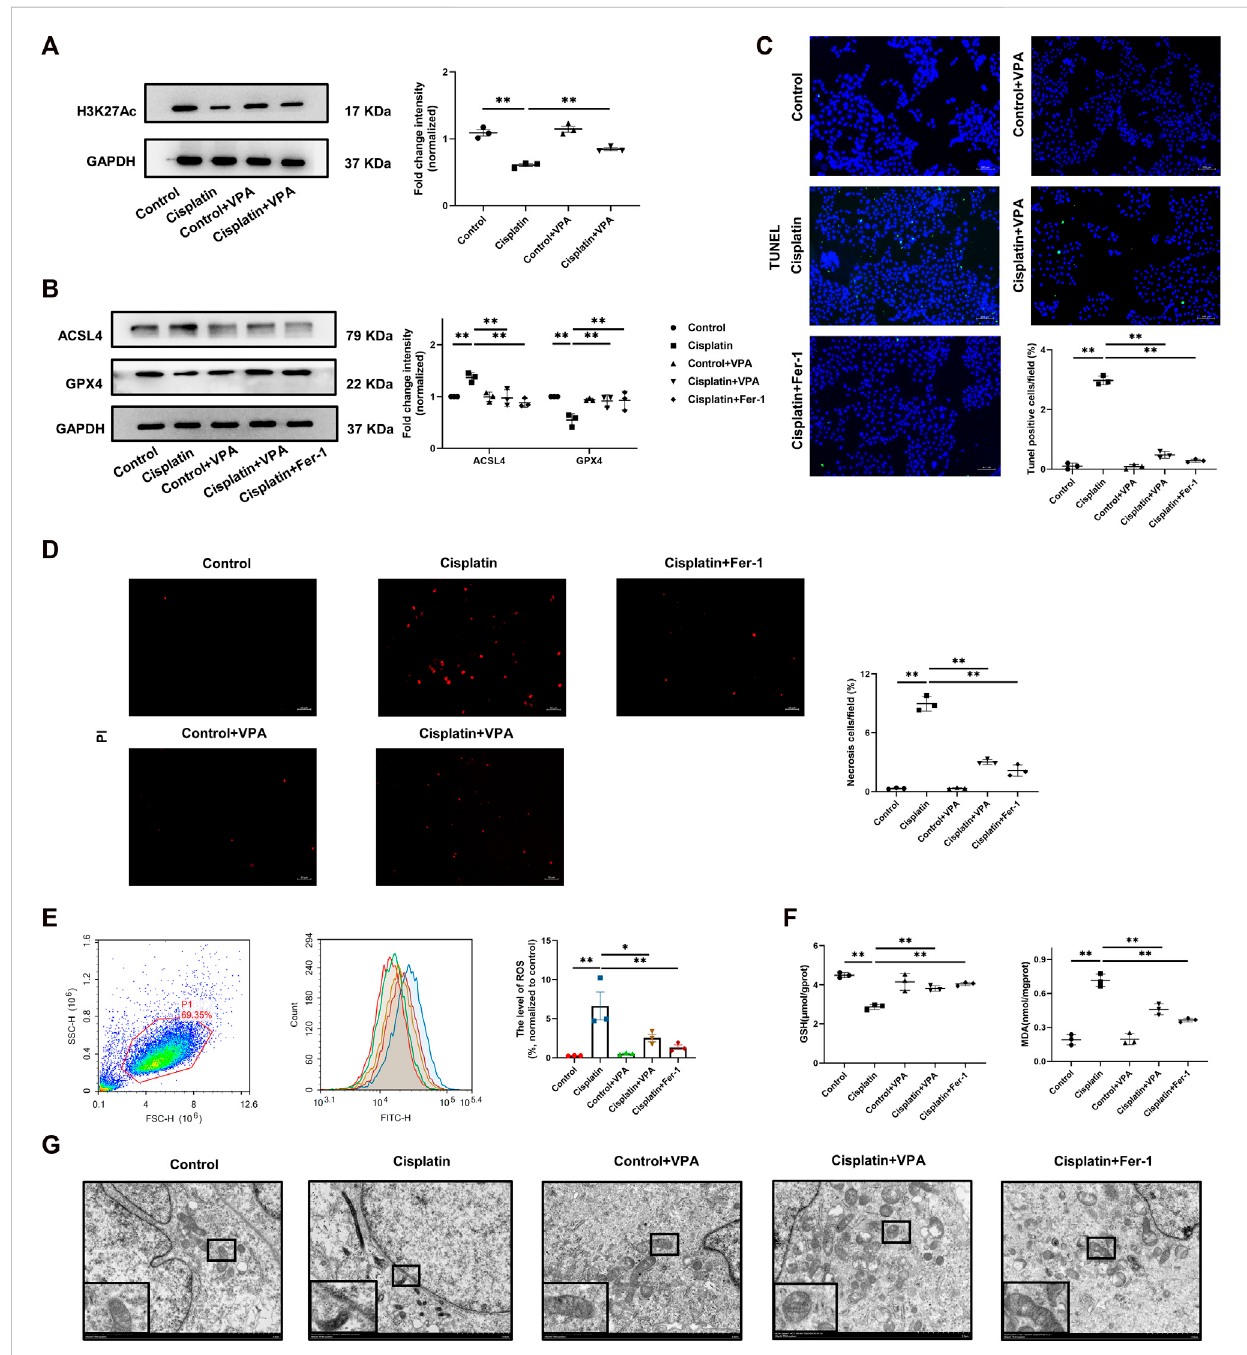
FIGURE 5 The cisplatin-induced ferroptosis is improved by VPA in HK-2 cells. Representative images of Western Blot and quanti fi cation of H3K27Ac in HK-2 cells stimulated by cisplatin (A) . Representative images of Western blot and quanti fi cation of ACSL4 and GPX4 in HK-2 cells stimulated by cisplatin (B) . PI staining (red) and statistical analysis of cell death in each group in HK-2 cells stimulated by cisplatin. Scale bar = 50 μ m (C) . TUNEL fl uorescence staining andstatisticalanalysisofapoptosiscellsineachgroupinHK-2 cellsstimulatedbycisplatin.Green fl uorescenceinpicturesrepresentpositivesignals ofapoptosiscells,whileblue fl uorescencerepresentsnuclearstaining (D) ,Scalebar=200 μ m.TheproductionofROSwasdetectedbyROSassaykitand waspresentasFITC-HvalueinP1region (E) .TheproductionofGSHandMDAincisplatin-stimulatedHK-2cells (F) .Transmissionelectronmicroscopyof HK-2 cell treated withcisplatin,VPA orFer-1 (G) , Scale bar=2 μ m. n= 3. ✱✱ value p < 0.01, ✱ value p < 0.05. Statisticallyanalyzed via aone-way